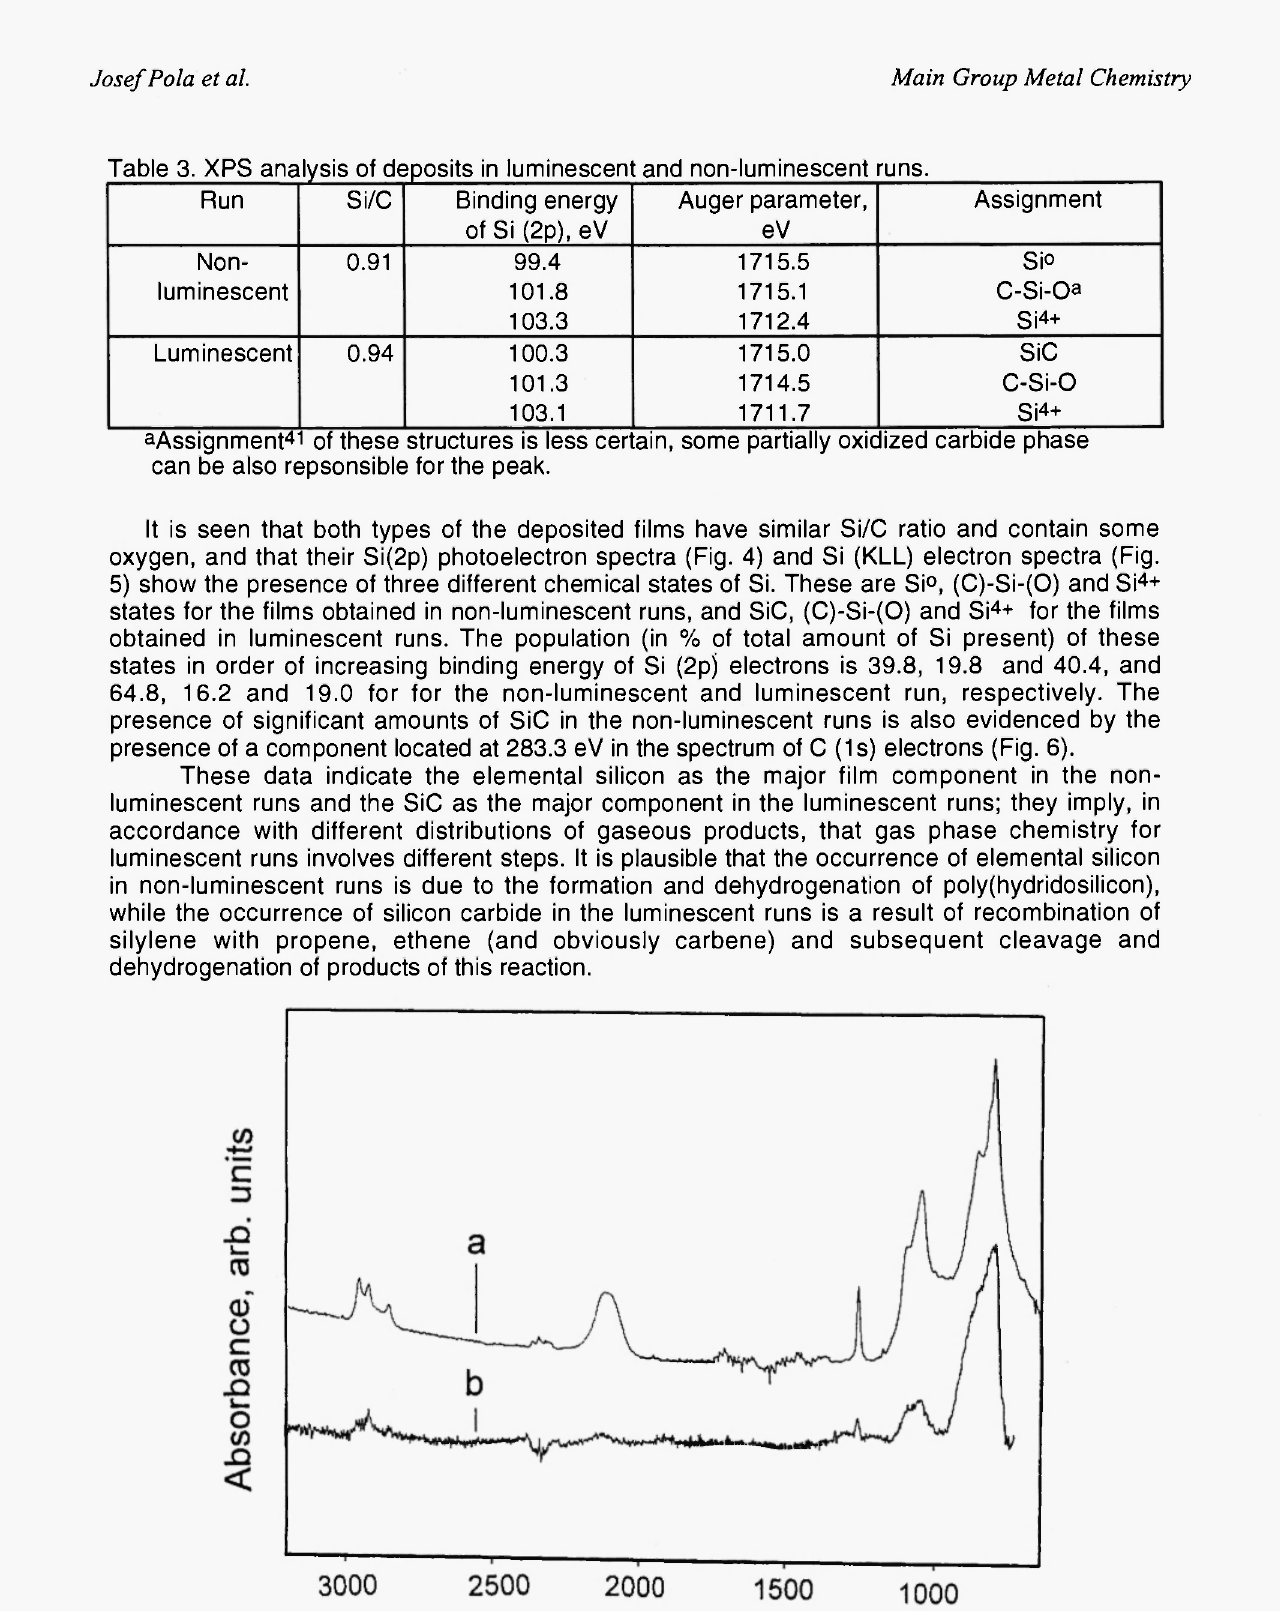
Fig. 3. FTIR spectrum of the deposits obtained by the P(30) line irradiation of ferf-butylsilane with low fluence (a, non-luminescent run) and high fluence (b, luminescent